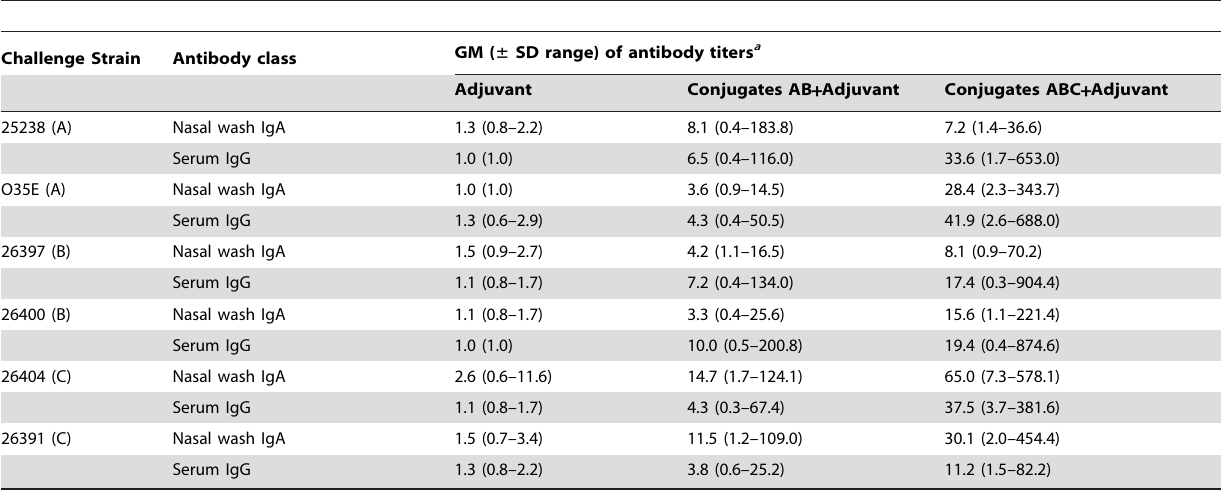
Table 2. Antibody responses of mice vaccinated with the combined conjugates after challenges with M. catarrhalis strains.